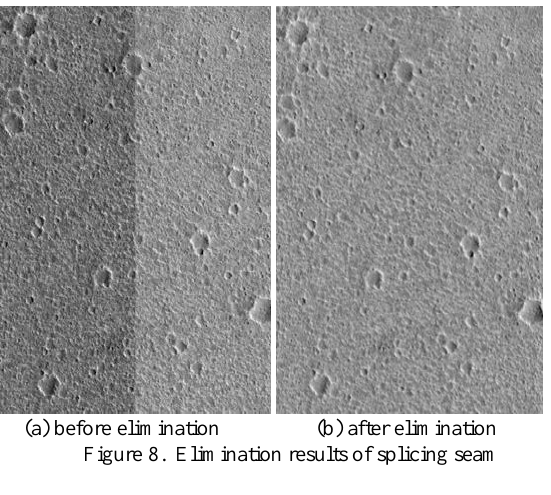
Figure 7. Radiometric calibration result of HiRISE imagery